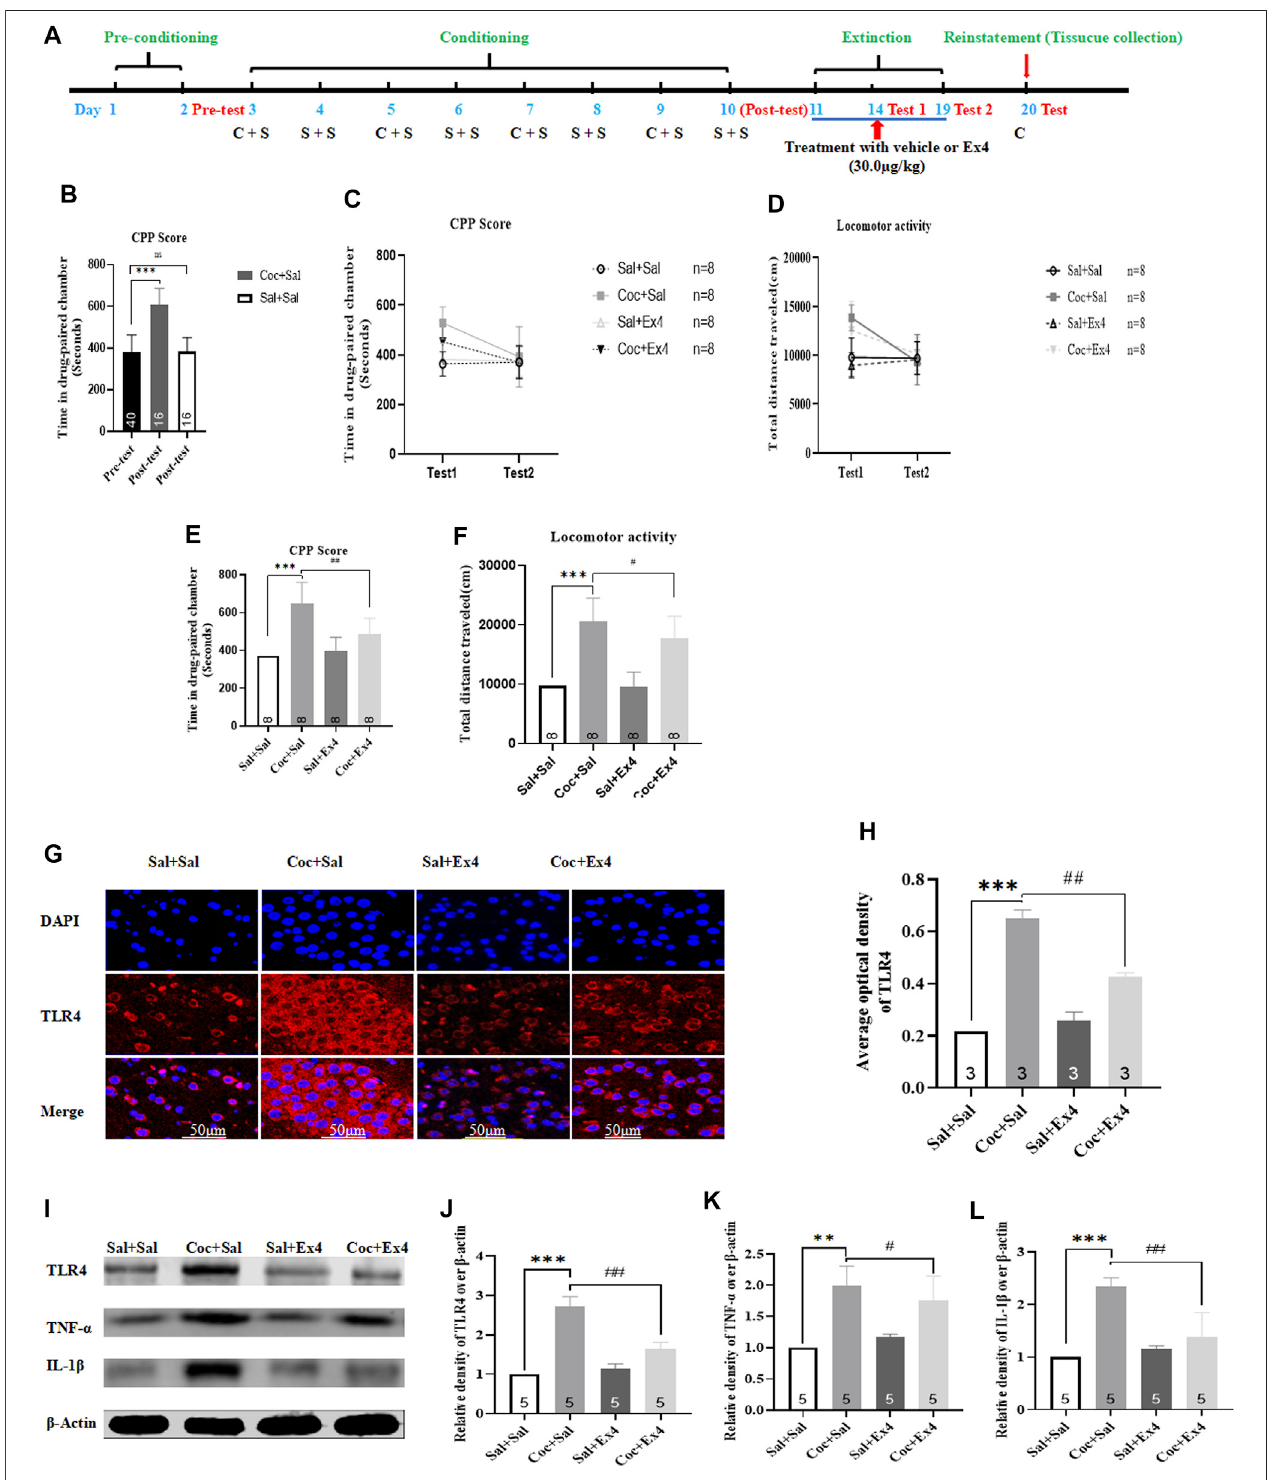
FIGURE 6 | Ex4 ’ s chronic treatment promotes extinction as well as suppresses reinstatement of cocaine-induced CPP and relieves expression levels of TLR4, TNF- α andIL-1 β . (A) Thecompleteexperimental scheduleforthebehavioralprocedureaswellassaline(S),cocaine(C),andEx4treatmentprotocols. (B) CPPscoresof the pre-test and post-test show that cocaine produced a signi fi cant CPP response after cocaine conditioning training. *** represents p < 0.001 vs pretest, Student ’ s t test. (C) CPP scores following post-extinction Ex4 treatment vehicle and Ex4 (30 μ g/kg) immediately after each extinction training show that Ex4 treated animals